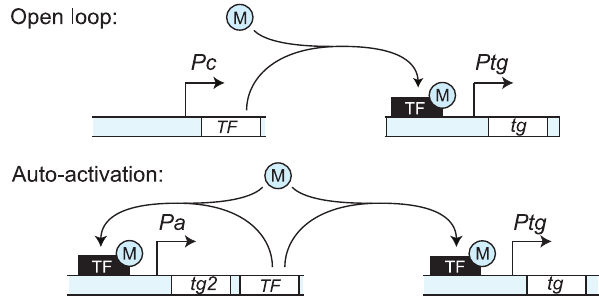
Figure 1. Open-loop vs. auto-regulation circuits. We consider genetic circuits consisting of a transcription factor (TF) that can regulate its target gene, gene tg , only if it is activated in response to some signal (shown here as modification M). We compare two alternative designs. In the first design, the open-loop circuit, the TF is constitutively expressed from promoter Pc and regulates its target gene by binding to its promoter, Ptg . In the second design, the auto-activation circuit, the TF in addition activates its own expression, from promoter Pa . In this case, additional genes in TF’s operon–such as gene tg2 –also respond to the signal. Both circuits are ubiquitous in